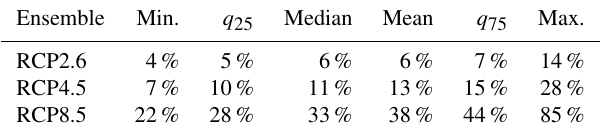
Table 2. Summary of the projected change from 2010 to 2100 in the 20-year return value for 24h precipitation under the assump- tion of stationary wet-day frequency. The sample comprises the 615 locations shown in Fig. 3. The numbers represent the change in per- centage with respect to year 2010.